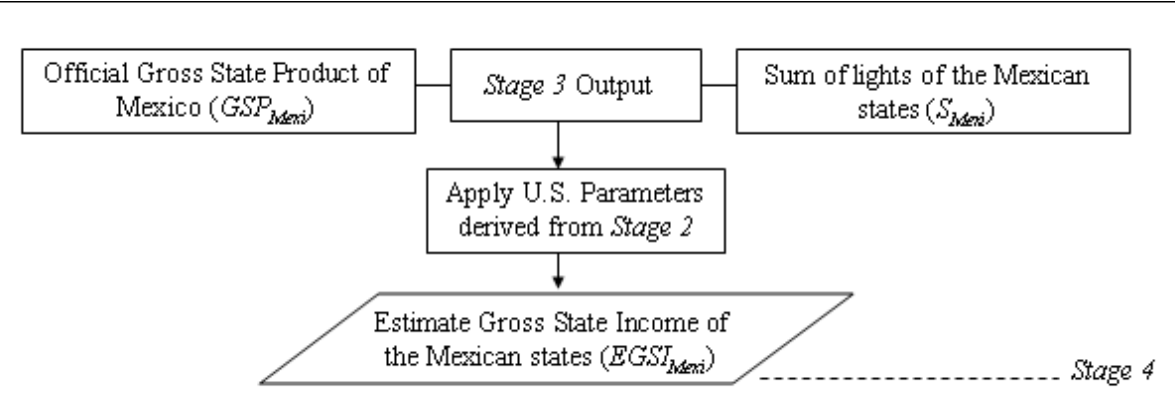
Figure 10. Stage 4 of the model: output is the Estimated Gross State Income of the Mexican states using the U.S. regression parameters derived from Stage